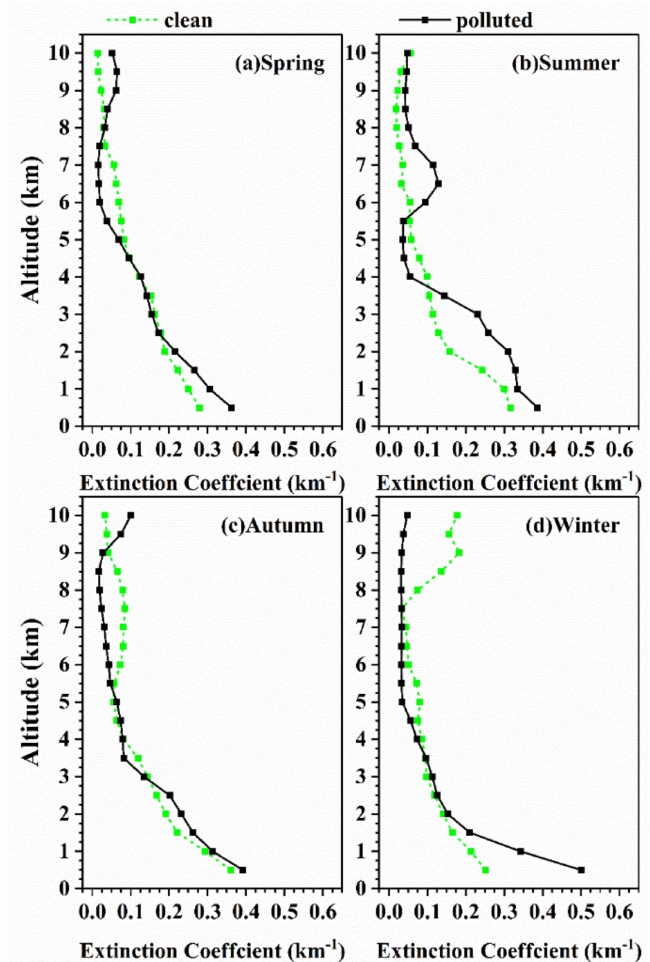
Figure 1. Multi-year seasonal mean vertical profiles of extinction coefficient in ( a ) spring; ( b ) summer; ( c ) autumn; ( d ) winter over Wuhan, China from 2013 to 2016 under different particulate air pollution